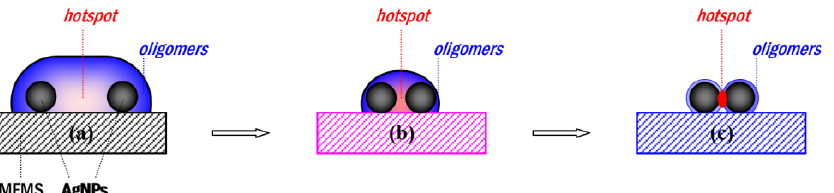
Figure 9. A schematic on the formation of the SERRS hotspots with MF oligomers participation: ( a ) a gap between two AgNPs is swollen by oligomers, ( b ) becomes small with the amount of oligomers decreased, and ( c ) works as an activated SERRS hotspot with the oligomers further decreased after the acid-treatment reaction.